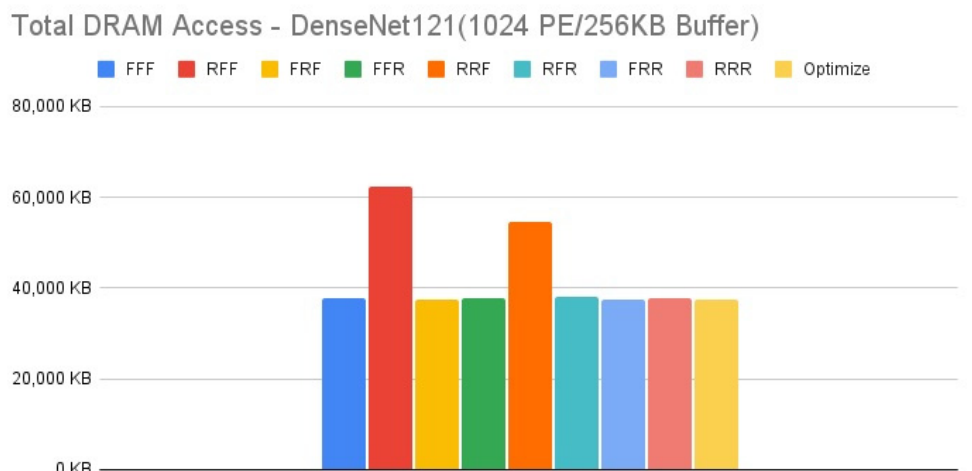
Figure 17. Total DRAM access—DenseNet121 (256 PE/256 KB Buffer).